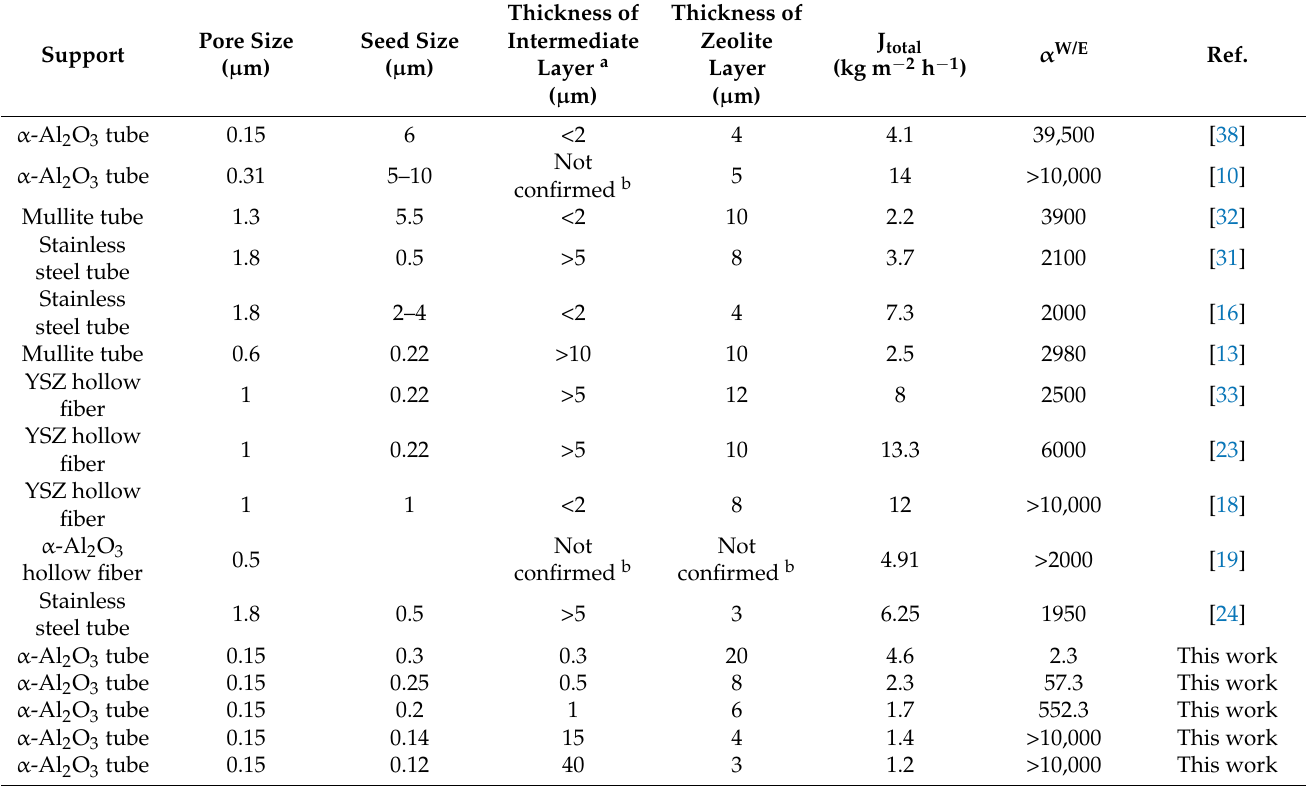
Table 2. Summary of the pervaporation performance of CHA zeolite membrane reported in literature and prepared in this work for a 90 wt.% ethanol-water